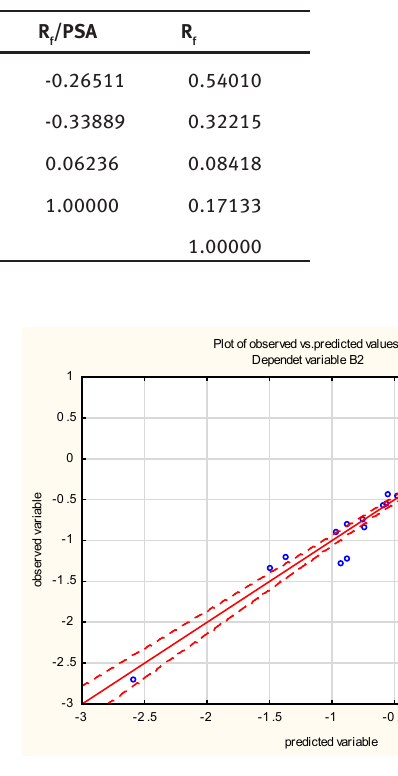
Figure 4: Plot of observed vs. predicted values for model ( 9 ). Dependent variable B2.